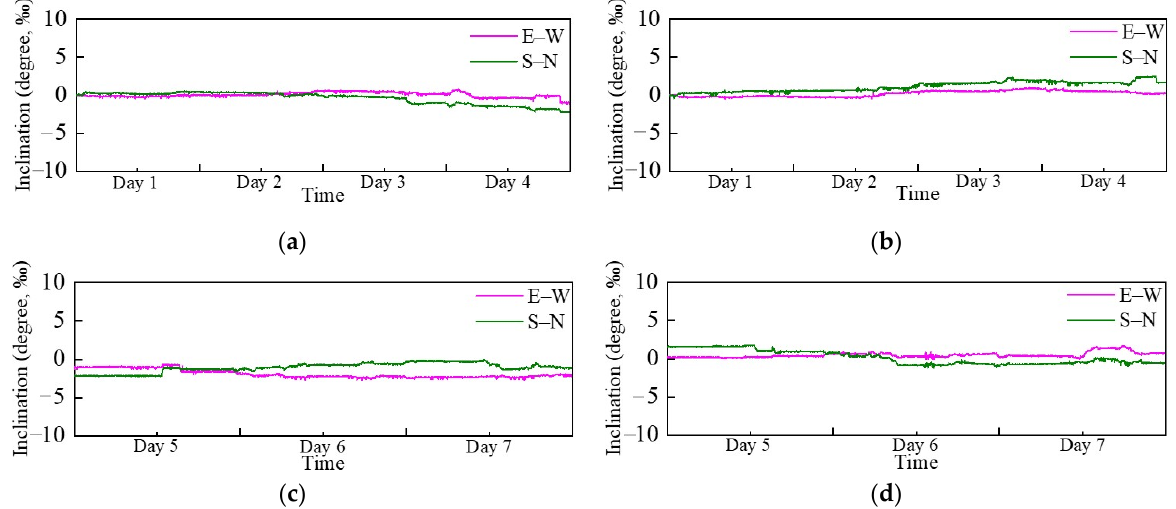
Figure 6. The obtained inclination angle: ( a ) W01 and ( b ) W02 during westward movement; ( c ) W01 and ( d ) W02 during northward movement.